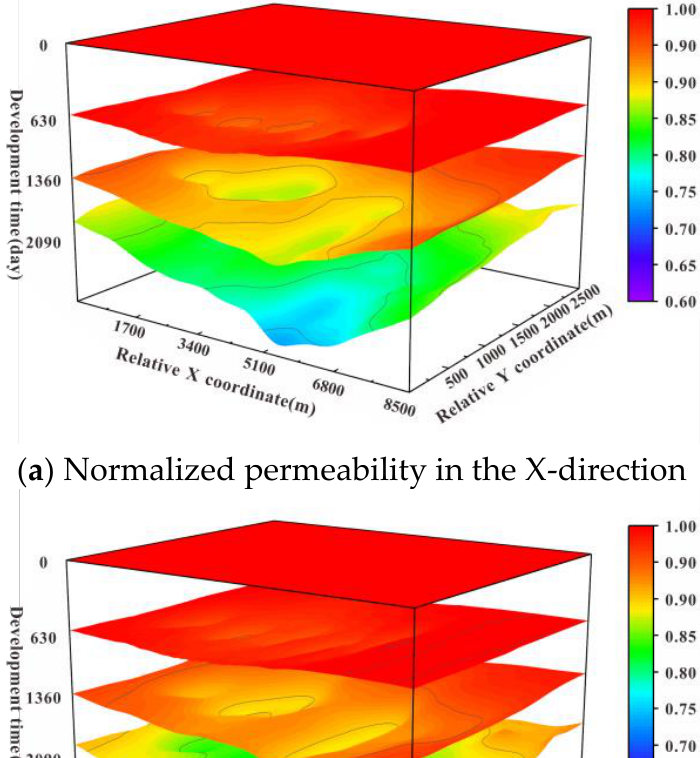
Figure 17. Normalized permeability contours of matrix systems.